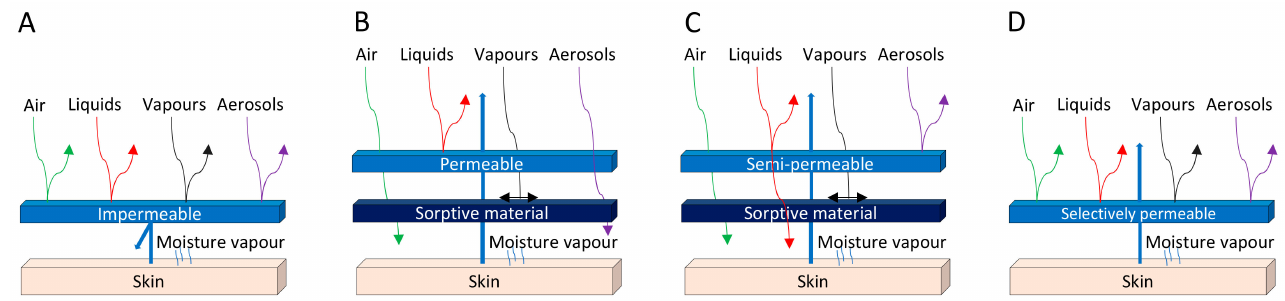
Figure 1. Schematic representation of the different types of conventional biological protec- tion: ( A ) impermeable membrane; ( B ) air-permeable shell layer; ( C ) semipermeable shell layer; ( D ) selectively permeable membrane (adapted from